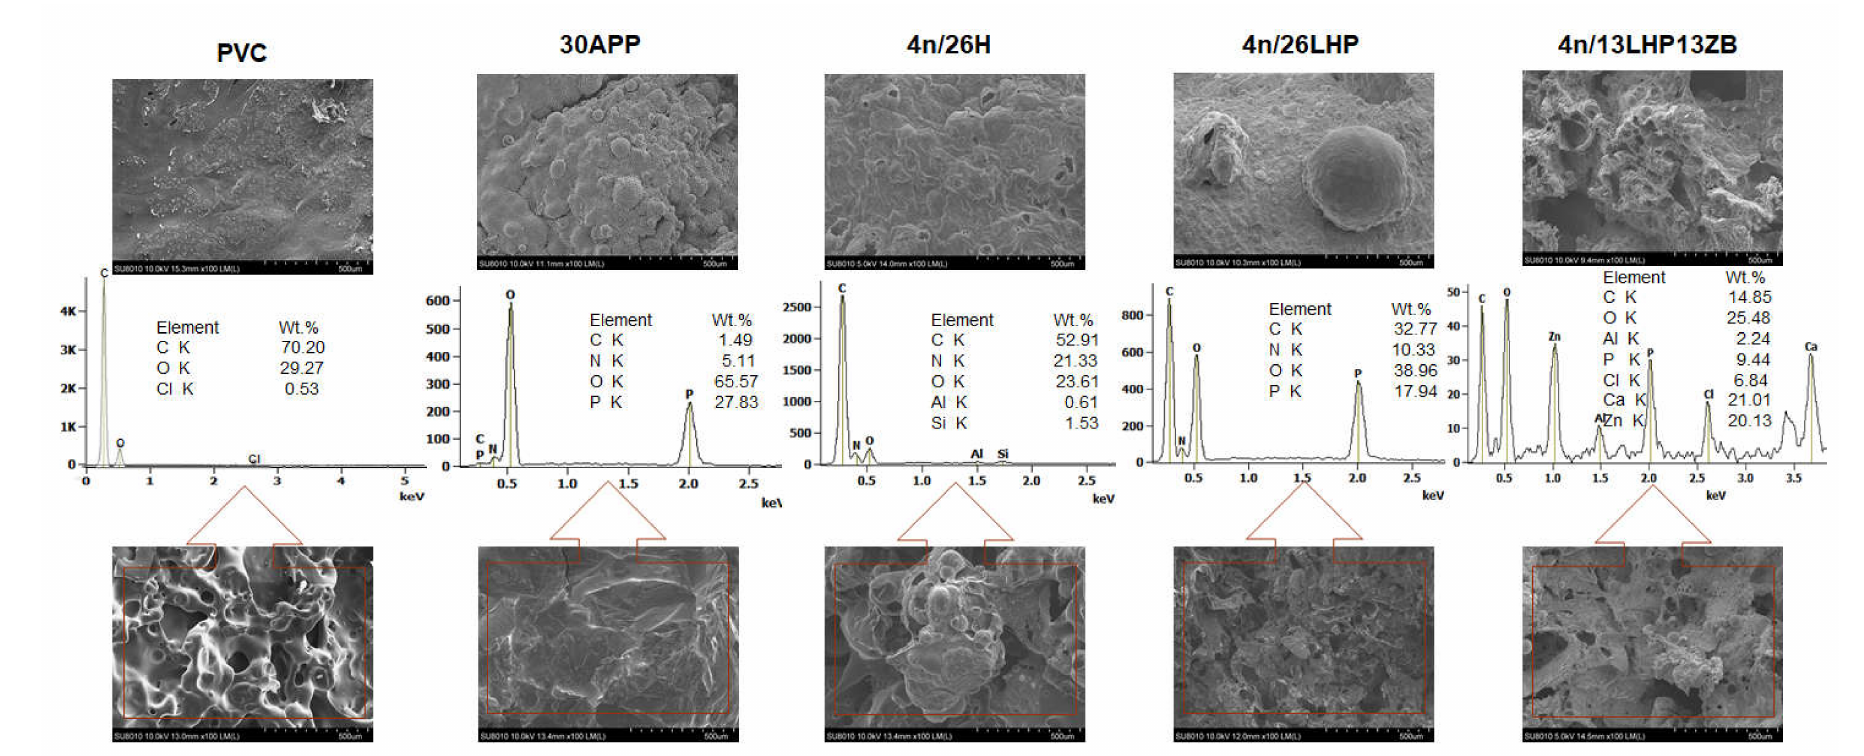
Figure 10. SEM images of PVC-P and PVC-P with APP or n/H, n/LHP, n/LHP/ZB systems after CC tests and EDS results (outer part of a char—top images and inner part of char—bottom